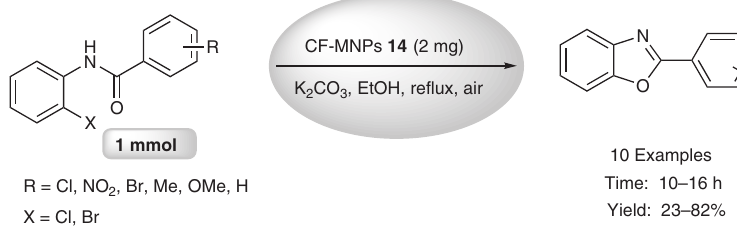
Scheme 16: CF-MNPs 14 catalyzed synthesis of